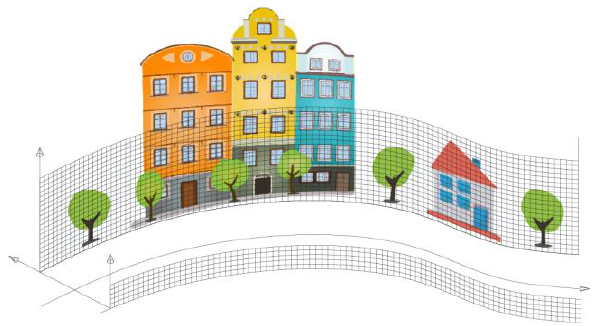
Figure 4. The coordinate system of the road with the corresponding grids of the left and right